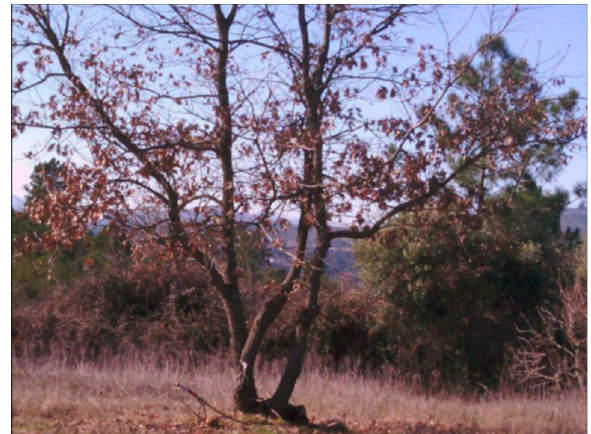
Figure 4. A photograph of the Quercus pyrenaica Willd tree taken at 2 p.m. under direct sunlight. Table 2. Characteristics of sample